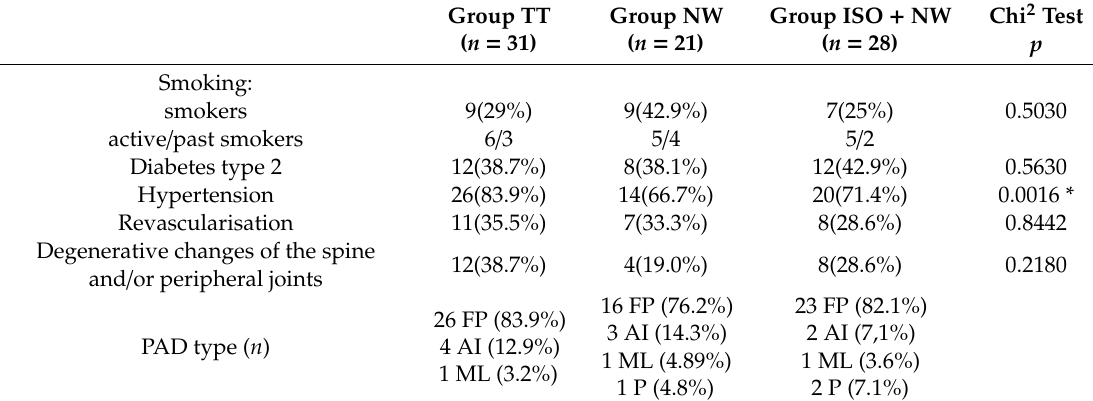
Table 2. Comorbidities and PAD levels of